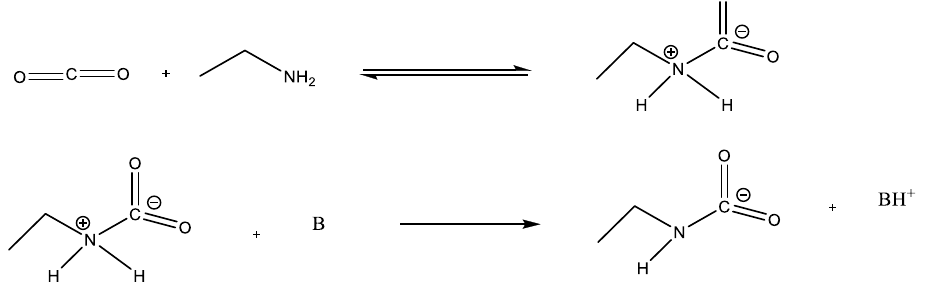
Figure 5. Reaction steps involved during zwitterion formation (Reprinted with permission from ref.